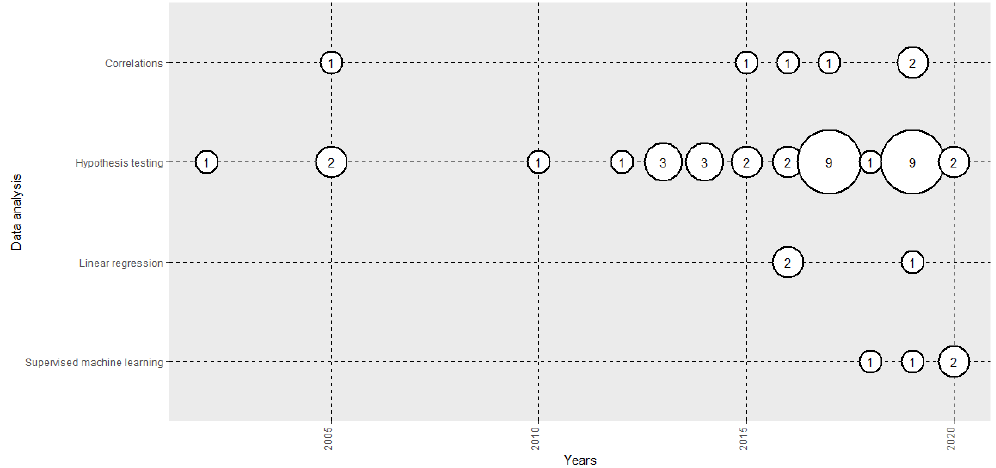
Figure 5. Evolution of the number of papers published each year by data analysis method used.